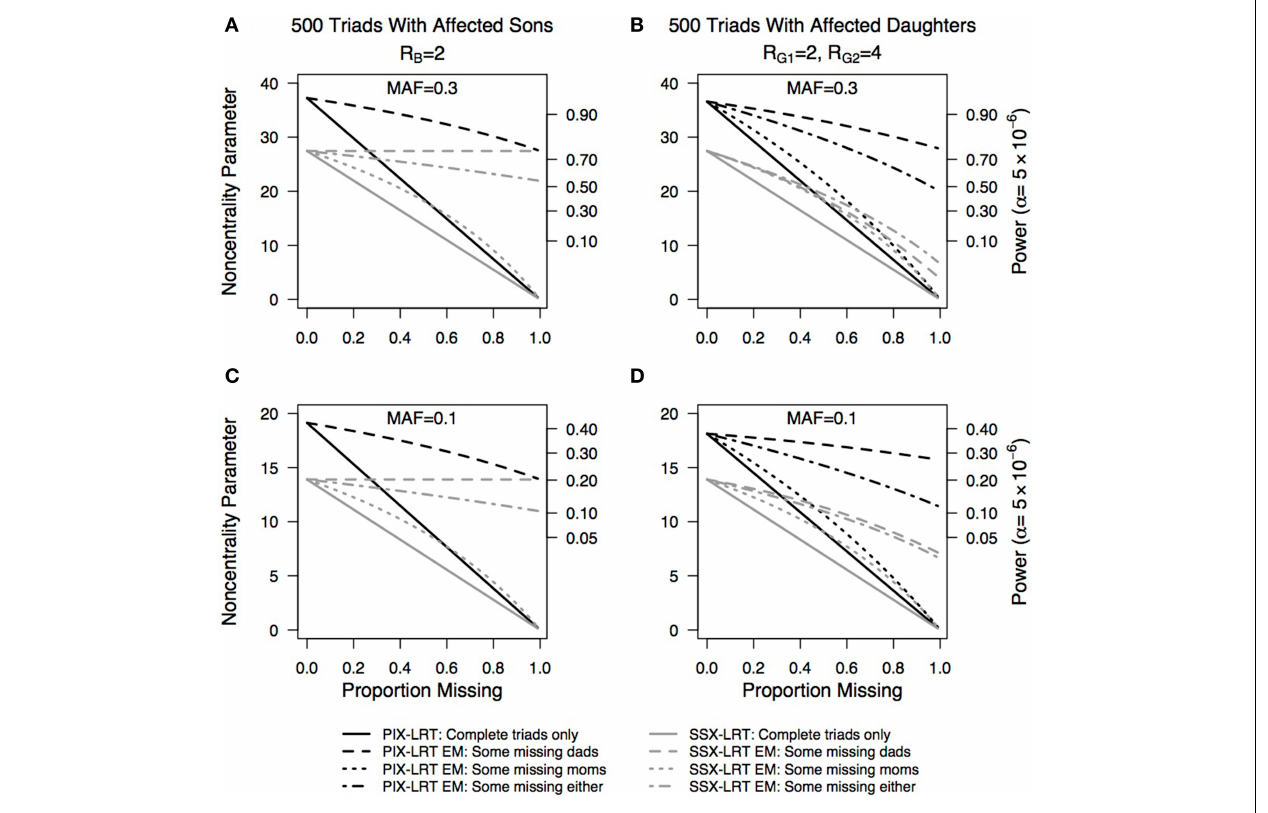
FIGURE 3 | Non-centrality parameter estimates as a function of missing parental genotypes using the Expectation-Maximization (EM) algorithm. PIX-LRT and SSX-LRT were run on (A,C) 500 triads with affected sons and R B = 2 and (B,D) 500 triads with affected daughters, R G 1 = 2 and R G 2 = 4. Minor allele frequencies of 0.3 (A,B) and 0.1 (C,D) were used. Black lines represent PIX-LRT results. Gray lines represent SSX-LRT results. Solid lines